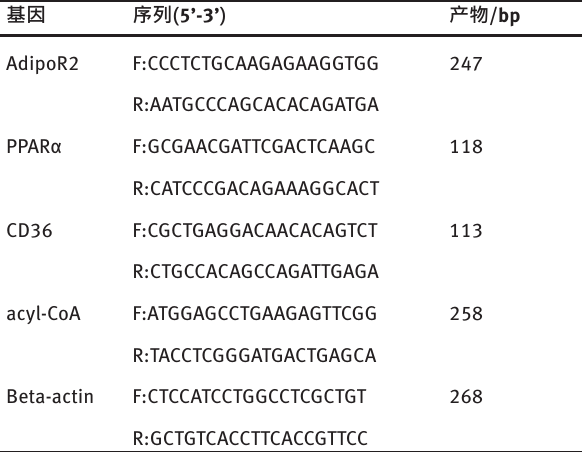
Table 1: List of PCR primers.